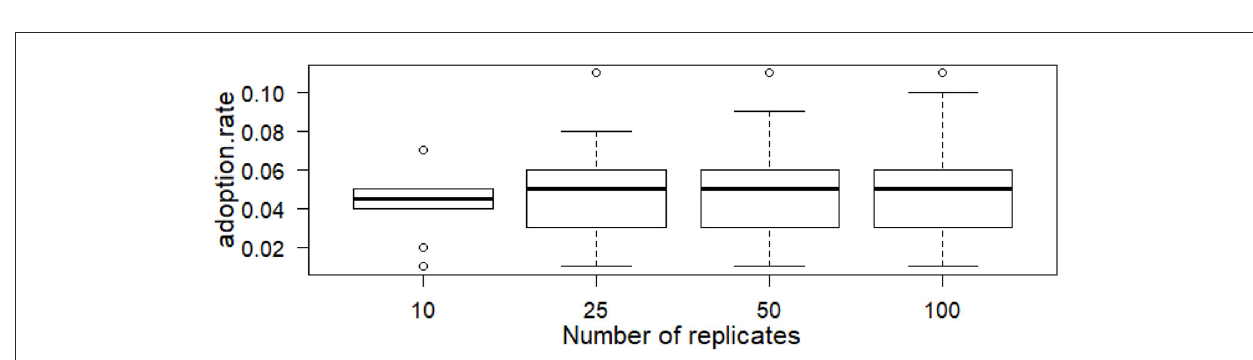
FIGURE5 Whiskers plots of the adoption rate for the different numbers of replicates. The black lines represent the median values; the boxes represent the interquartile range (IQR), the whiskers represent the minimum/maximum excluding 1.5 IQR outliers. Points are outliers beyond that